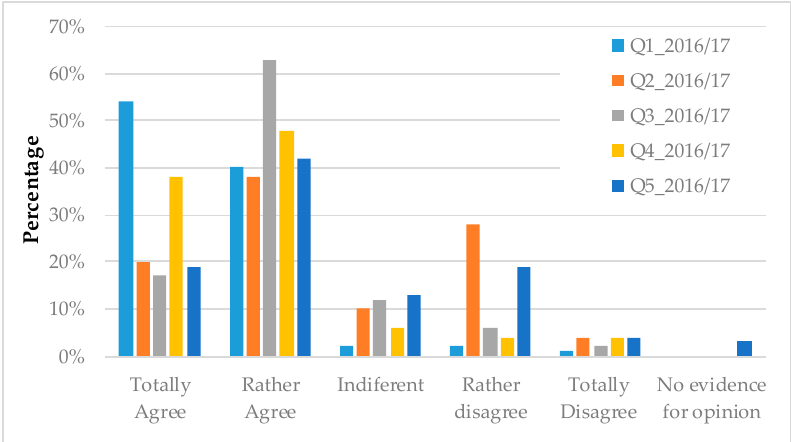
Figure 6. Survey to analyze the development of the project in fluid facilities. Table 4. Questions related to coordination between years.